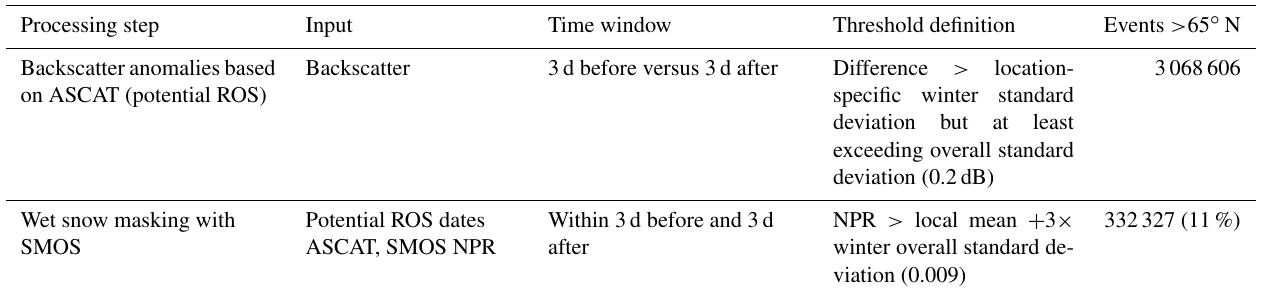
Figure 6. Comparison of Metop ASCAT C-VV (cid:49)σ 0 with (a) snow surface temperature and (b) snow water equivalent. Source: snowpit data at Sodankylä BOG site for 2009–2015, temperatures below 0 ◦ C and SWE > 0. Table 2. Processing steps and results for potential rain-on-snow (ROS) identification by fusion of ASCAT backscatter and SMOS normalized polarization ratio (NPR). Events represent November–February of the years